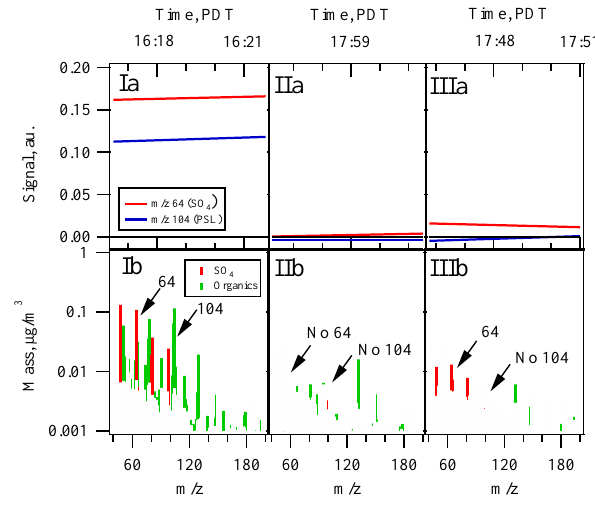
Fig. 5. Aerosol concentration and composition for experiments where ammonium sulfate and PSL spheres were externally mixed. Panel (Ia) is the time series of sulfate and PSL mass spectra sig- nal before the CCNC and PCVI. The AMS average mass spectrum during this period is given in (Ib) . (IIa) is the same quantities as in (Ia) but after the CCNC and PCVI at 0.25% saturation when the saturation was not sufficient to form droplets that have a larger size than the PCVI cut-size from either particle type (see Figs. 2 and 3). The concurrent spectrum is given in (IIb) . Panel (III) shows that the saturation (0.75%) was sufficient to activate droplets from am- monium sulfate and the formed droplets were large enough to pass the PCVI whereas PSL spheres did not activate (see Figs. 2 and 3). Note that only ammonium sulfate, and not PSL signal, is evident in (IIIa) and the mass spectrum in (IIIb)